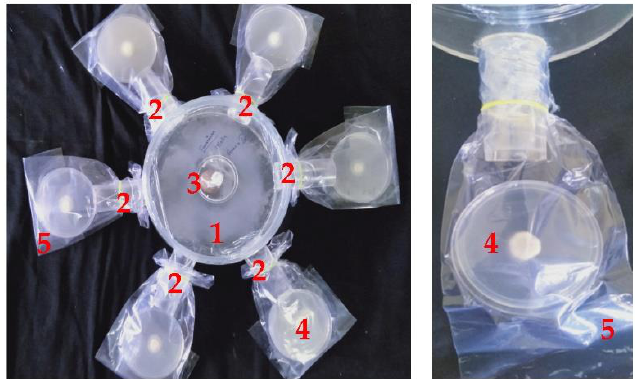
Figure 2. In vitro efficacy of VOCs immobilized vermiculite ball using olfactory chamber, V — Ver-